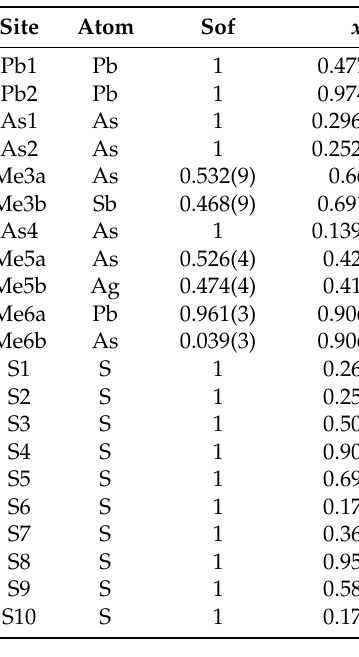
Table 6. Fractional atomic coordinates and displacement parameters (in Å 2 ) for sample